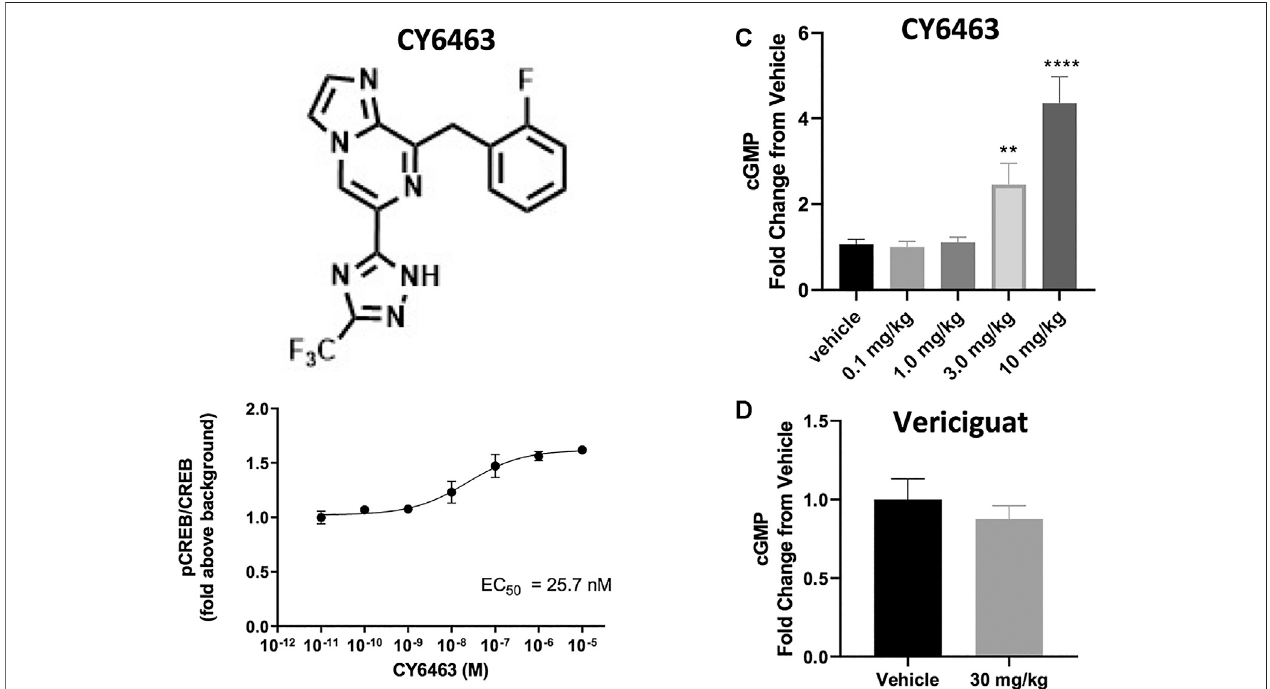
FIGURE 1 | (A) , Chemical structure of CY6463 (8-(2- fl uorobenzyl)-6-(3-(tri fl uoromethyl)-1 H -1,2,4-triazol-5-yl)imidazo [1,2- a ]pyrazine). (B) , Effect of CY6463 on CREB phosphorylation in rat primary neurons. Representative concentration response of CY6463 as measured by cellular phosphorylation of CREB in the presence of 10 µM DETA-NONOate in ratprimary neurons. Dataare normalized tovehicle control. Each datapoint representsthe mean from three replicates. (C) , concentrationsof cGMP in the CSF were higher in rats dosed orally with 3 or 10 mg/kg CY6463. ( p (cid:2) 0.0057 for the 3-mg/kg dose and p < 0.0001 for the 10-mg/kg dose; Kruskal- Wallis test followed by the uncorrected Dunn ’ s test). (D) , cGMP levels in the CSF in rats dosed orally with 30 mg/kg vericiguat were similar to those dosed with vehicle. ** p < 0.01, **** p < 0.0001. All data are expressed as mean ± SEM.